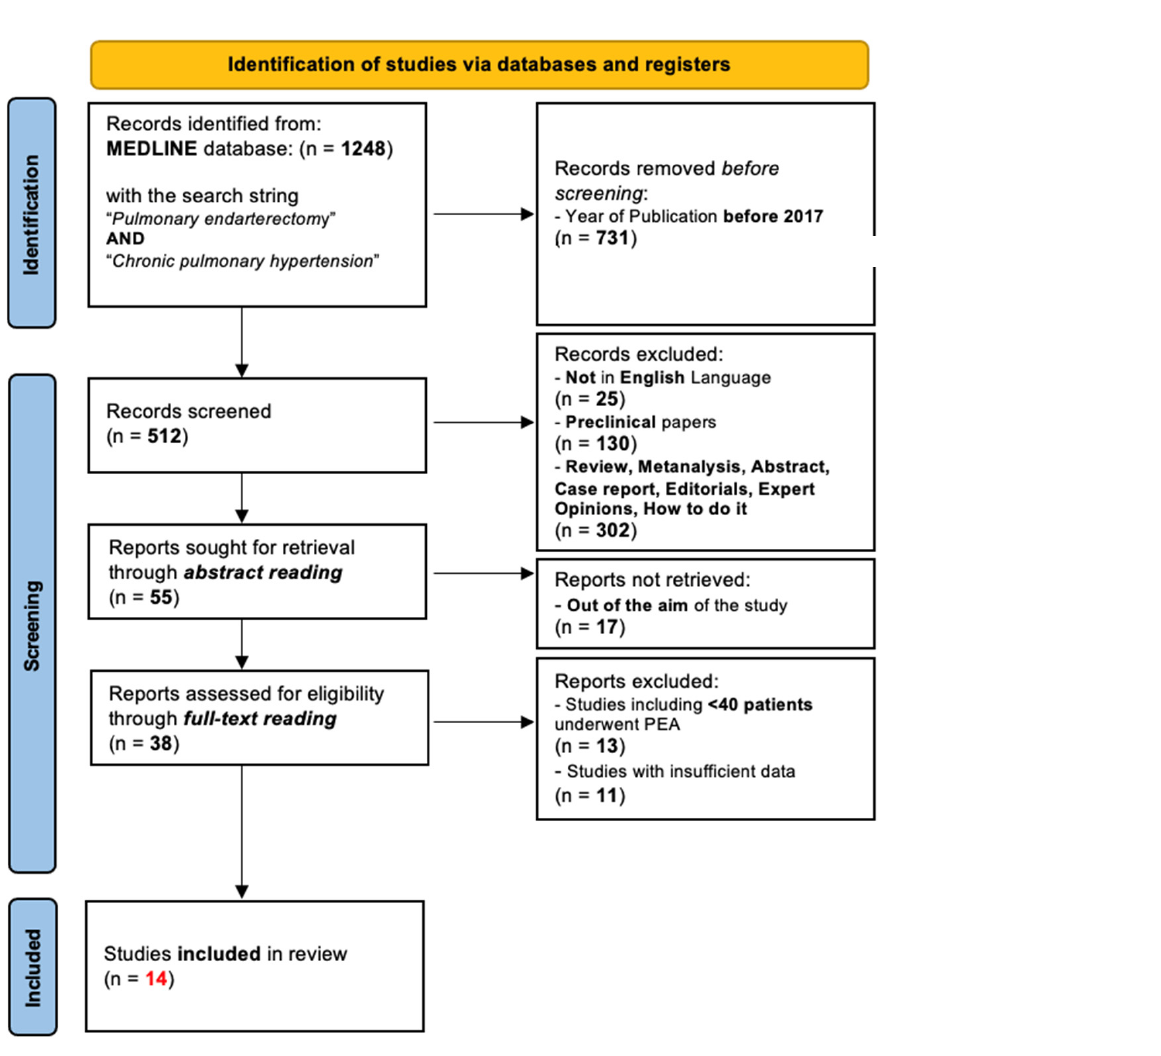
Figure 1. PRISMA flow diagram for this systematic review [22].